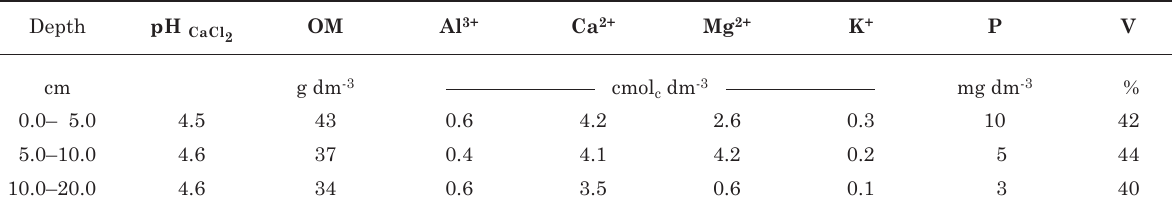
table 1. Soil chemical properties prior to the experiment depth